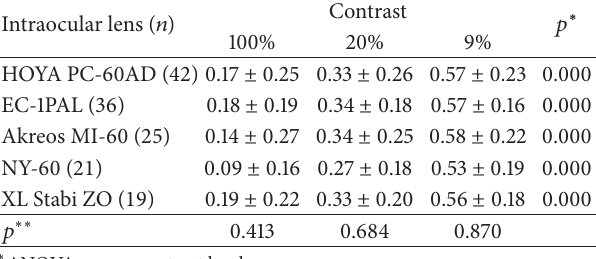
Table 4: Simulated visual acuity (mean VA logMAR ± SD) of pseu- dophakic eyes ( 𝑁 = 143 ) at different contrast levels, compared by intraocular lens